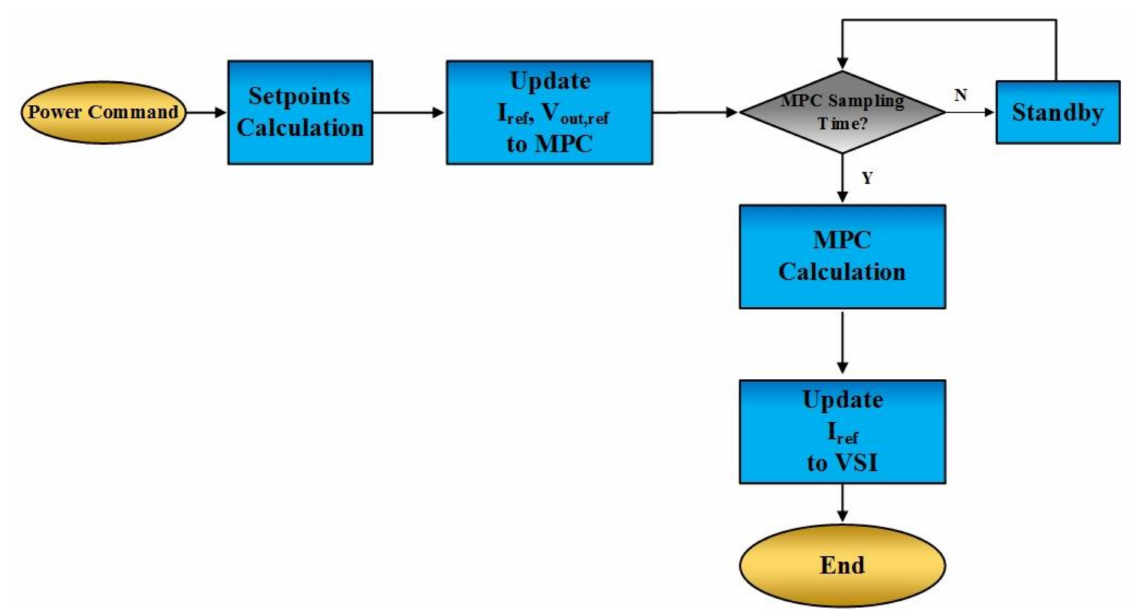
Figure 6. The logical flow chart for fuel starvation